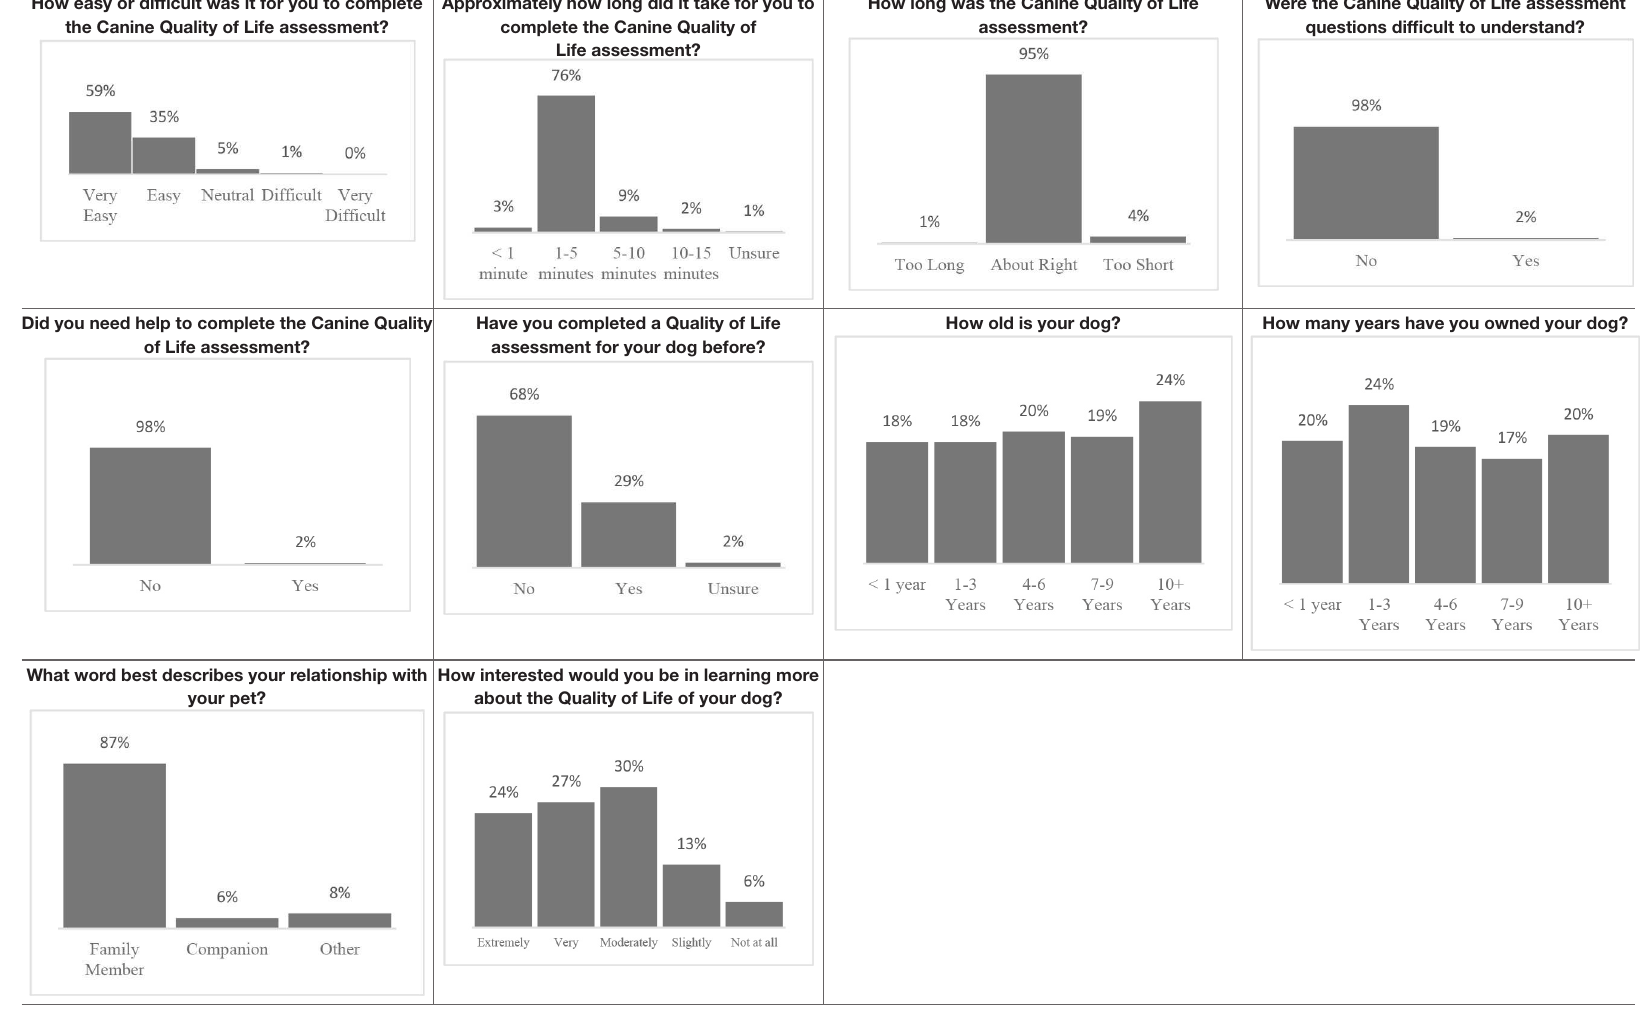
TABLE 2 | Phase 1 usability assessment survey results. How easy or difficult was it for you to complete the Canine Quality of Life